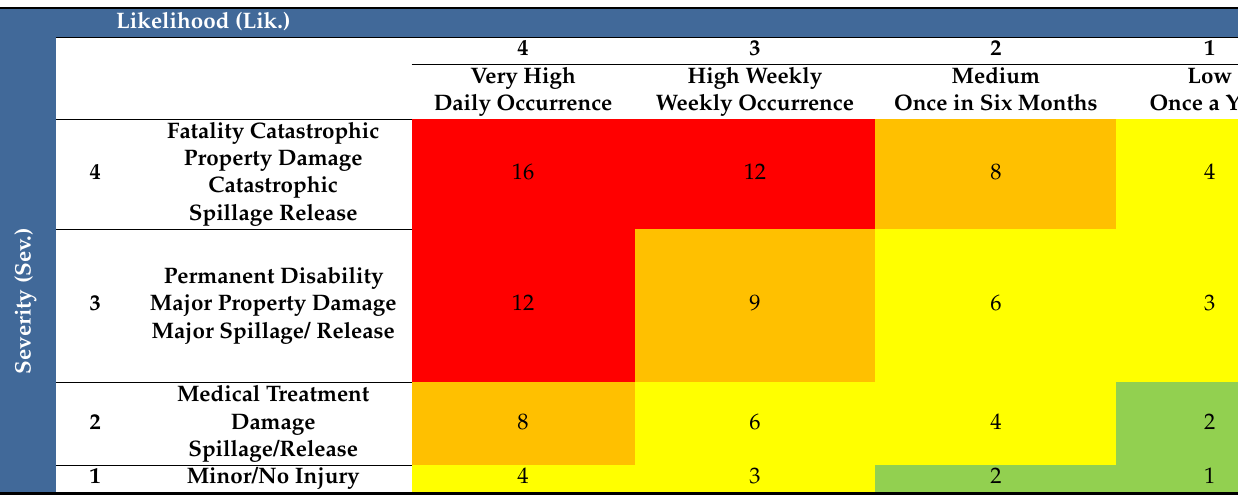
Table 1. Probability impact